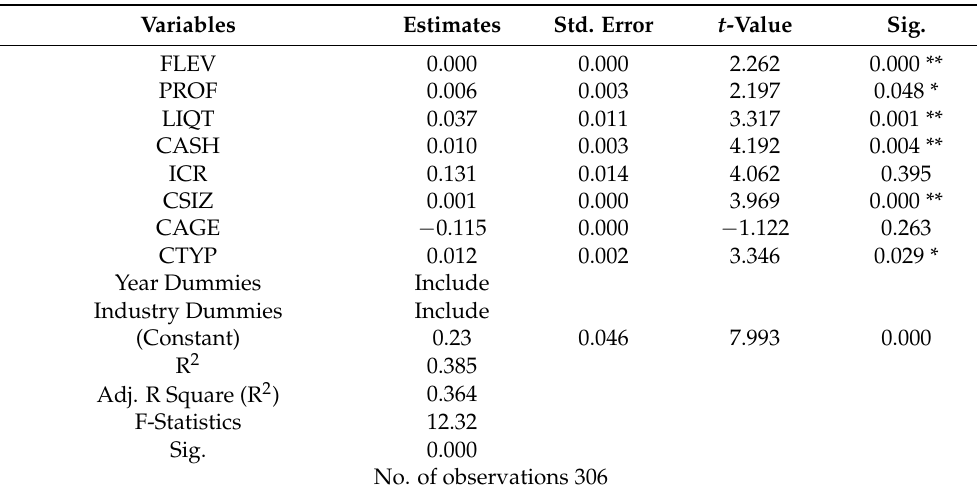
Table 7. Regression analysis results.